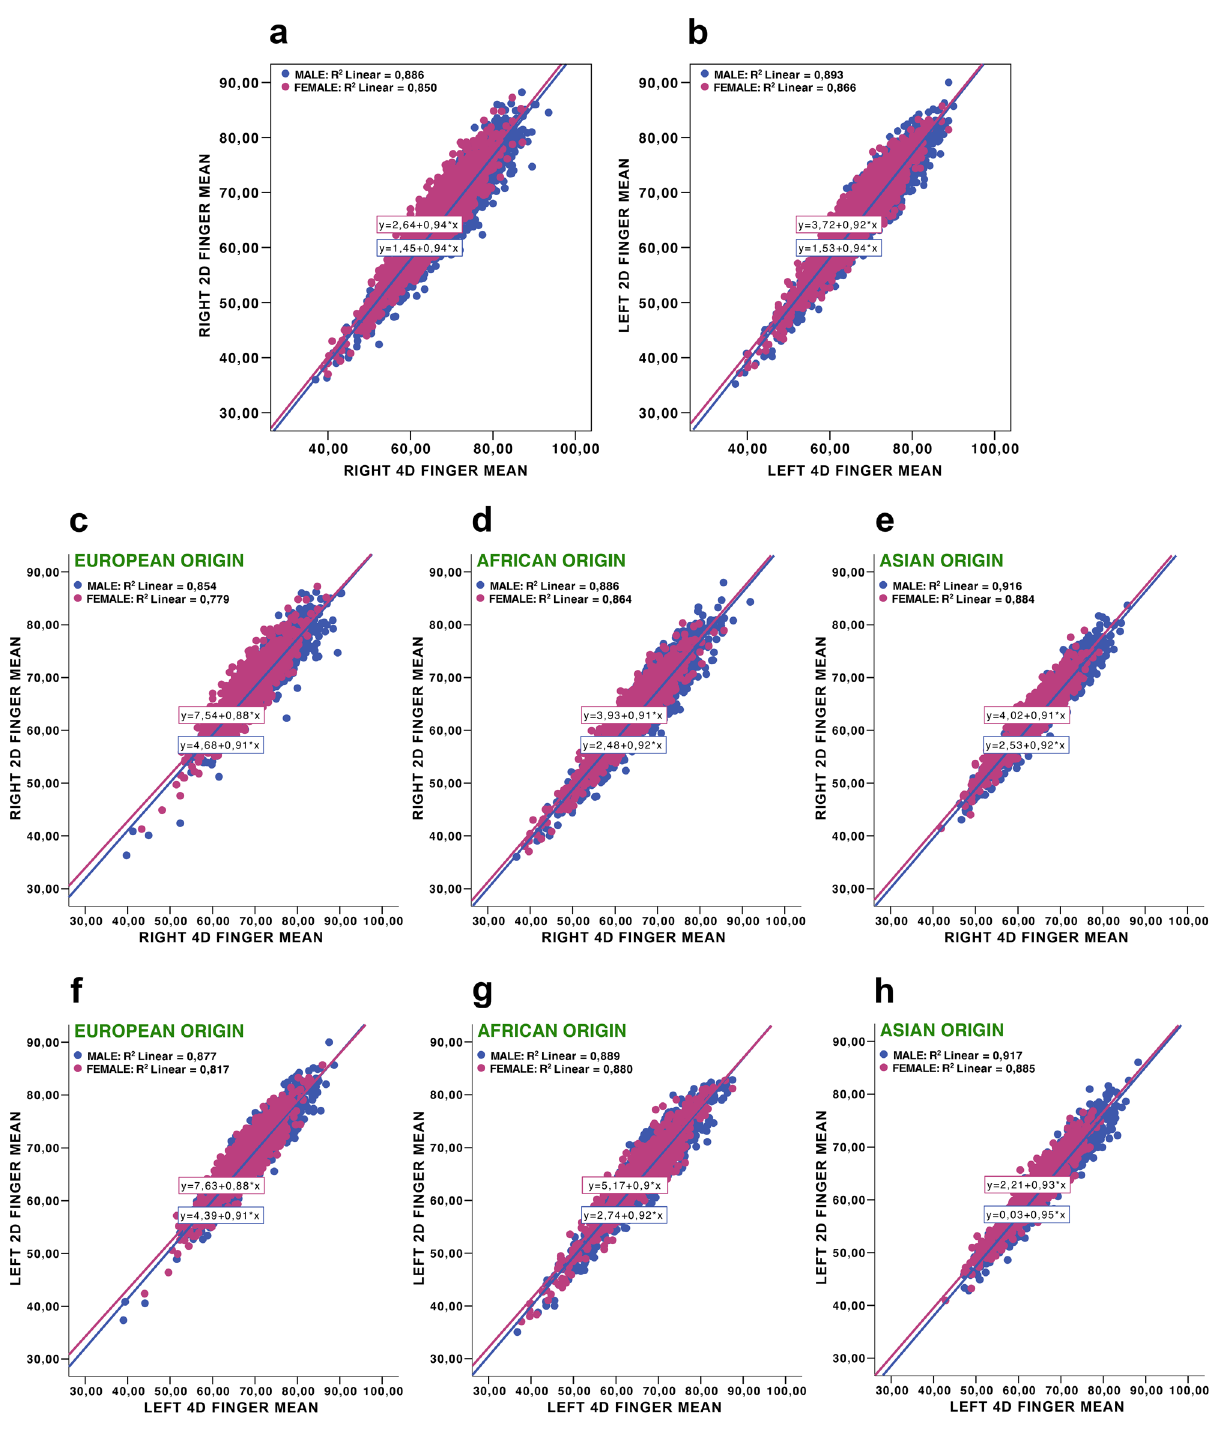
Figure 1. Ratio 2D finger means to 4D finger means: right 2D finger means to right 4D finger means in total sample ( a ), left 2D finger means to left 4D finger means in total sample ( b ), ratio right 2D finger means to right 4D finger means in three populations (European origin ( c ), African origin ( d ), Asian origin ( e )), ratio left 2D finger mean to left 4D finger mean in three populations (European origin ( f ), African origin ( g ), Asian origin ( h